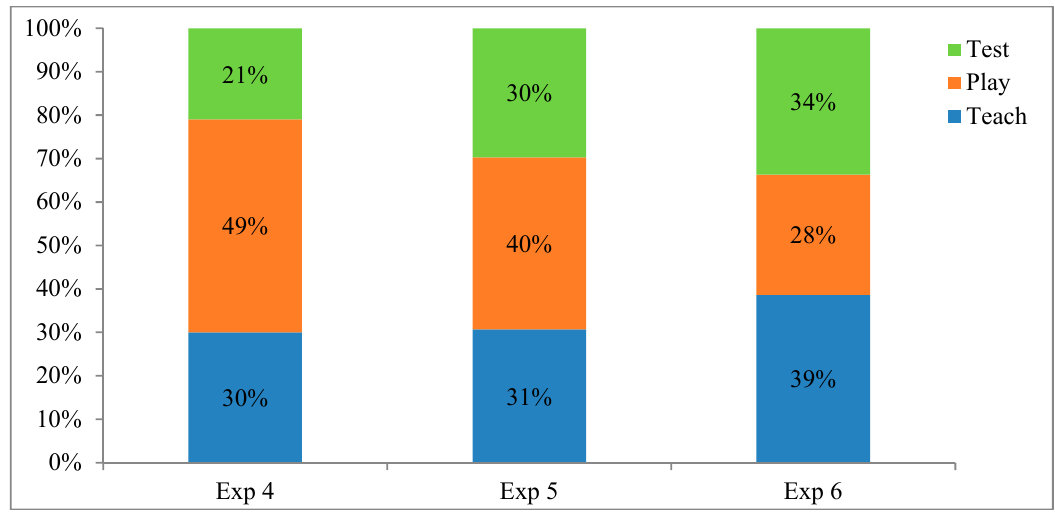
Figure 5 . Percentage of teach, play, and test sections by experiment for CYCLES Training Center . Note: values do not add up to 100% because of other components, such as narrative, which is not counted here.